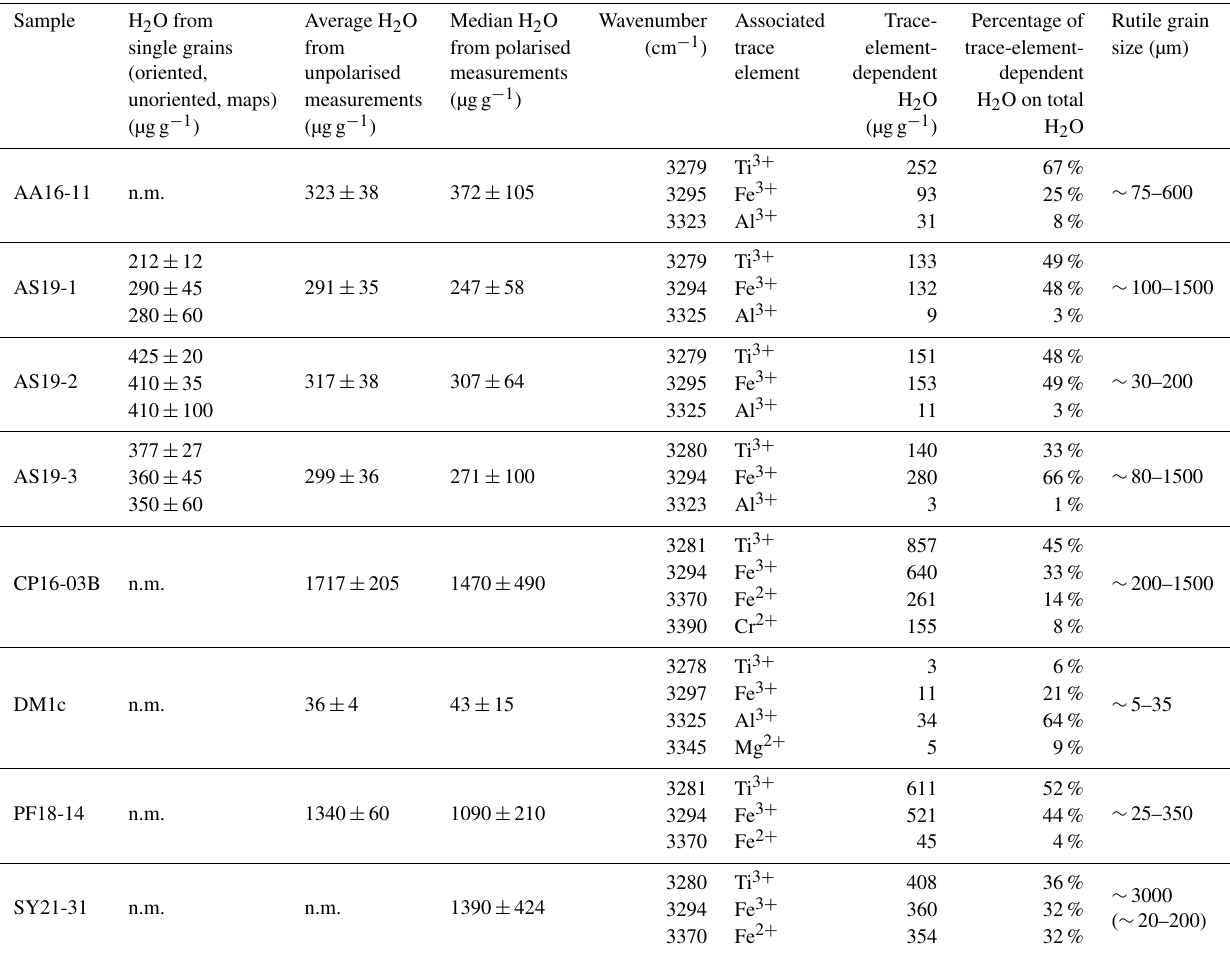
Table 4. Total- and trace-element-dependent IR absorbance and H 2 O content in the 3200–3500cm − 1 range of thick-section samples. Errors are given at 2 σ . n.m. – not measured. Grain sizes for SY21-31 represent whole grain and crushed grains. Sample H 2 O from Average H 2 O Median H 2 O Associated Trace- Percentage of Rutile grain single grains from from polarised (cm − 1 ) trace element- trace-element- size (µm) (oriented, unpolarised